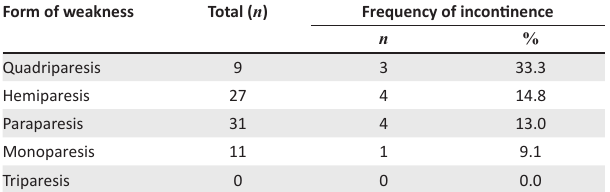
TABLE 6: Incontinence in association with forms of weakness.